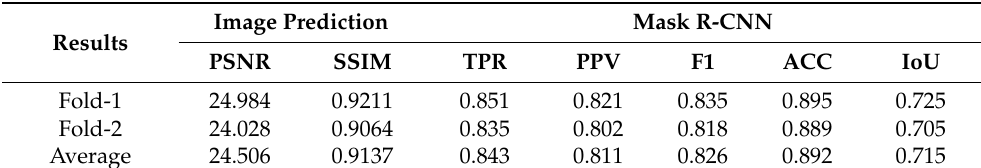
Figure 17. Example images of datasets in fold-1. ( a ) Example images used in training phase; ( b ) example images used in testing phase. Table 15. Accuracies of image prediction and human segmentation by the proposed method using two different datasets.